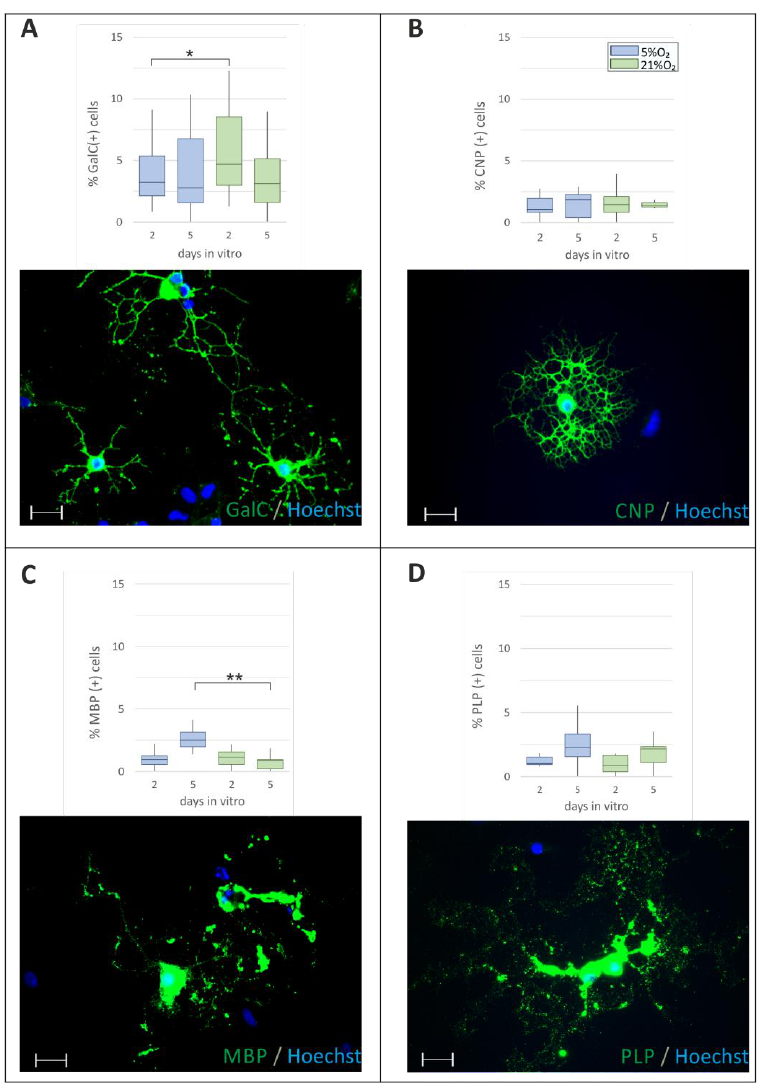
Figure 4. Quantification of maturating oligodendrocytes maintained in different culture conditions for either 2 or 5 DIV. The cells were cultured either in 5% ( blue bars ) or 21% O 2 ( green bars) . ( A ) Differentiating, multiprocessed cells are characterized by the presence of the GalC antigen on the cell surface; ( B ) Expression of CNP (2′,3′-Cyclic-nucleotide 3′-phosphodiesterase), the characteristic marker of the oligodendroglial lineage; ( C ) Detection of myelin basic proteins (MPB) in differentiated oligodendrocytes with branched cell processes; ( D ) Presence of proteolipid protein (PLP) in mature cells. The cell nuclei were labelled with Hoechst 33258 ( blue ). The scale bar corresponds to 20 µm. The calculated differences were considered statistically significant if: * p < 0.05, ** p < 0.01.